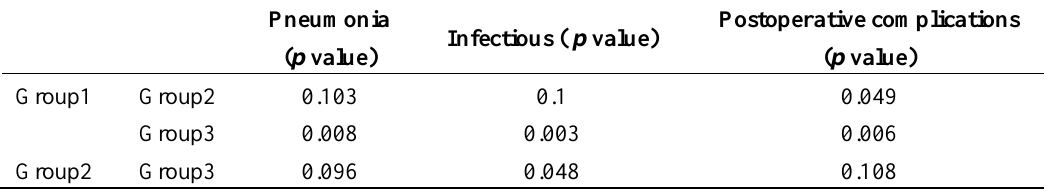
Table 3. Multiple comparison among groups ( p